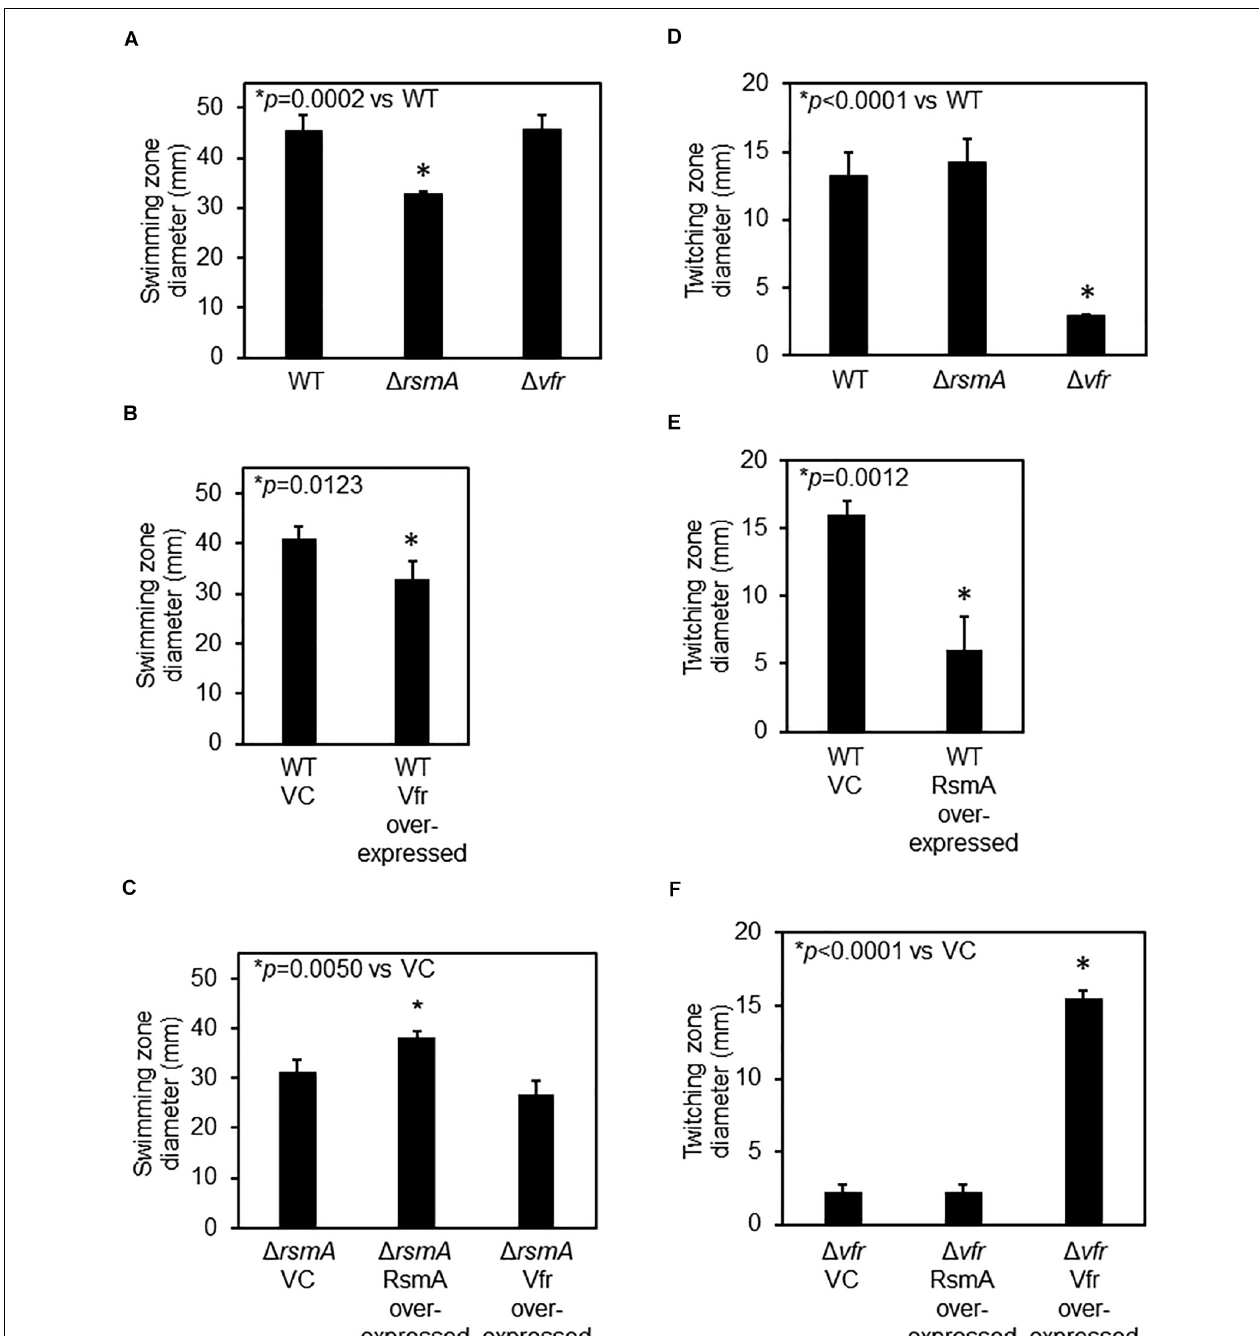
FIGURE 2 | RsmA regulatory cascade affects flagellar and Type IV pilus-mediated motilities. (A) Flagellar-mediated swimming motility is decreased for the (cid:49) rsmA strain but not the (cid:49) vfr strain. (B) Vfr over-expression leads to decreased swimming motility. VC, vector control. Motility assays for VC and Vfr over-expressing strains were performed in the presence of 300 µ g · ml − 1 of carbenicillin to ensure maintenance of the plasmids. (C) There is no statistical significance difference between the swimming motility of (cid:49) rsmA and Vfr over-expression strains, indicating that Vfr is epistatically downstream of and in the same regulatory pathway as RsmA. Motility assays for these plasmid-containing strains were performed in the presence of 300 µ g · ml − 1 of carbenicillin. (D) Type IV pilus-mediated twitching motility is reduced for (cid:49) vfr as compared with wild type (WT). (E) RsmA over-expression leads to decreased twitching motility. Motility assays for VC and the RsmA over-expressing strain were performed in the presence of 300 µ g · ml − 1 of carbenicillin. (F) RsmA over-expression in (cid:49) vfr does not affect the low twitching motility of the parental (cid:49) vfr . Motility assays for these plasmid-containing strains were performed in the presence of 300 µ g · ml − 1 of carbenicillin.